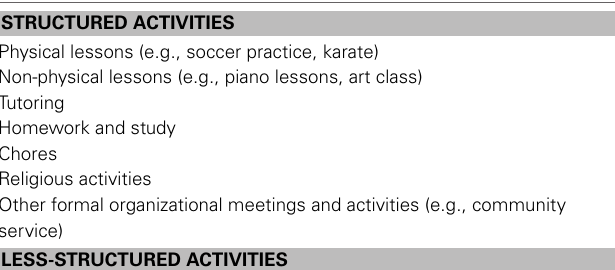
Table 1 | Classification of child time use (structured, less-structured, and other